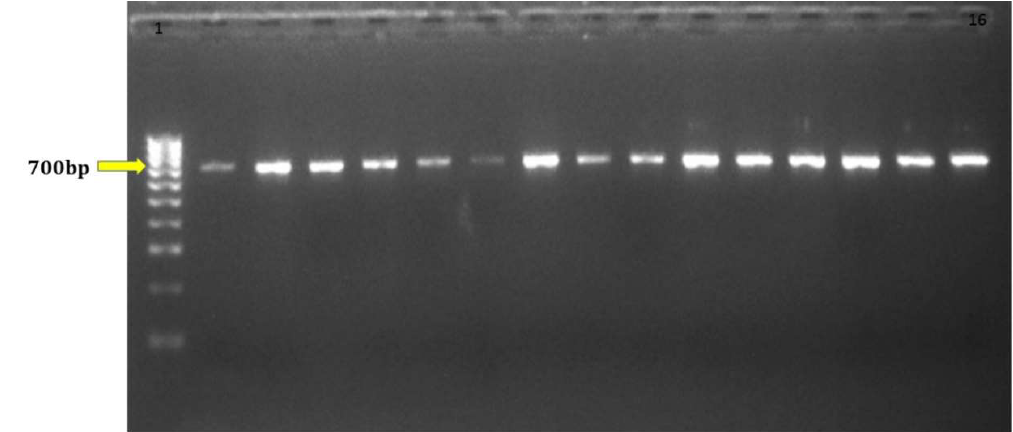
Figure 2. Polymerase chain reaction species identification of T. absoluta species. A characteristic band of 658 bp typical to metazoans is evident in lanes 2–16. Lane 1 represents HypperLadder IV from Bioline (~1013 bp).